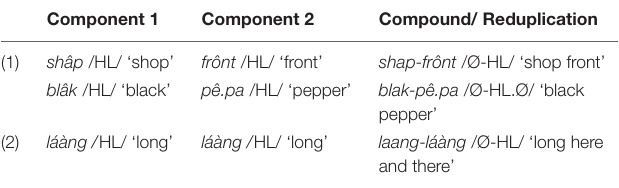
TABLE 4 | Tonal derivation of compounds and reduplications in Guyanese